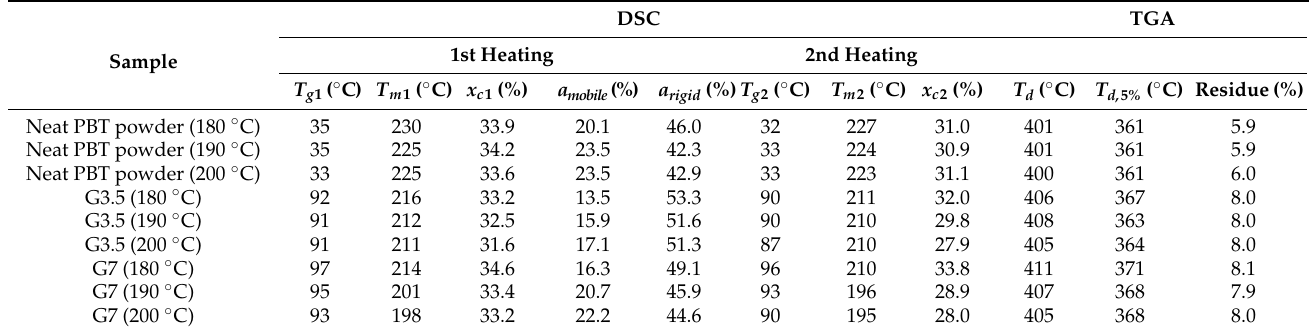
Table 3. Thermal properties of the neat PBT powder and vitrimers at the end of the solid-state repolymerization (t = 3 h) at three different temperatures (180, 190, 200 ◦ C).